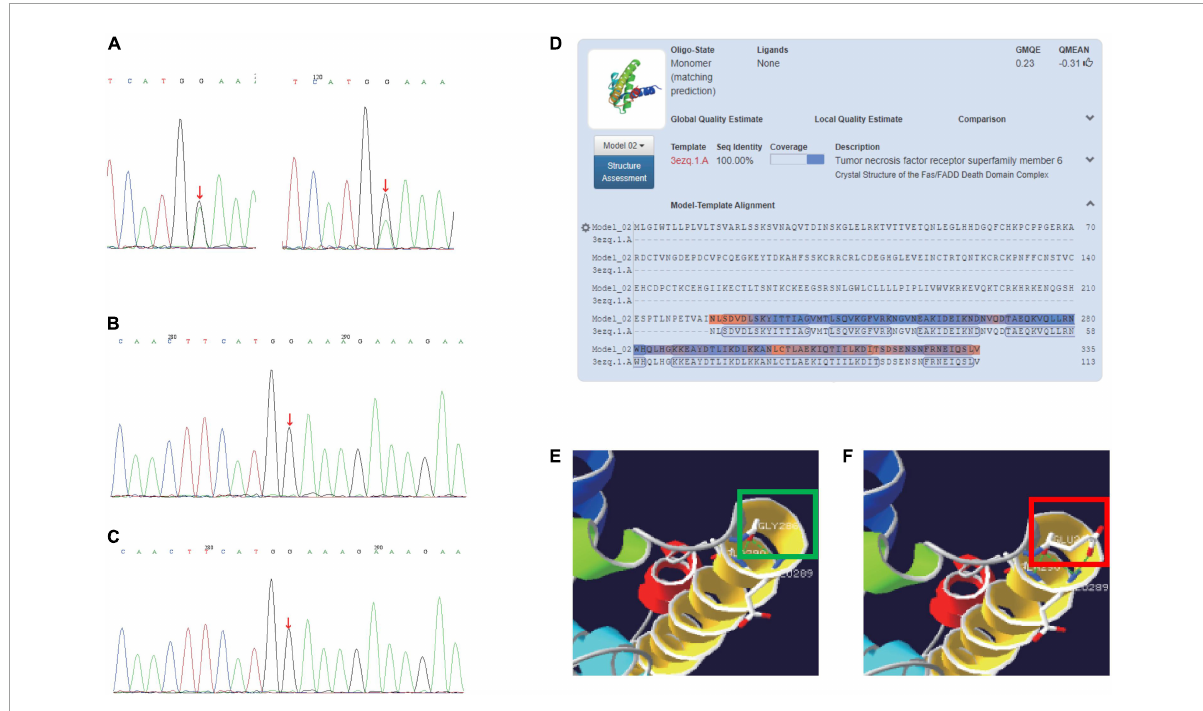
FIGURE1 (A) Sanger sequencing of the FAS gene (c.857G > A, p.G286E) germlinemutation of patients (left: DNA of patient’s peripheral blood; right: DNA of patient’s nail). (B) Sanger sequencing of father’s FAS gene. (C) Sanger sequencing of mother’s FAS gene. (D) Crystal structure of the FAS/FADD death domain complex (3ezq.1.A). (E) A hydrogen bond is formed between amino acids 286G and 289E; a hydrogen bond is formed between amino acid 286G and 290A. (F) A total of two hydrogen bonds are formed between amino acids 286E and 289E; A hydrogen bond is formed between amino acid 286E and 290A. The green and red squares in panels (E,F) show the difference of hydrogen bond formation between wildtype and the